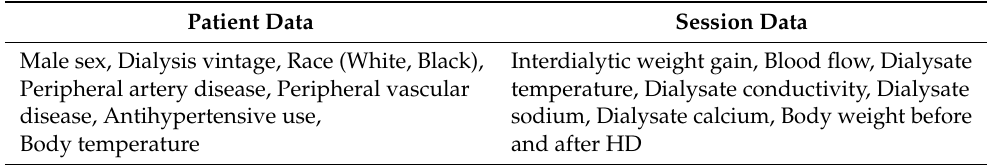
Table 6. Additional parameters that may be considered. Patient